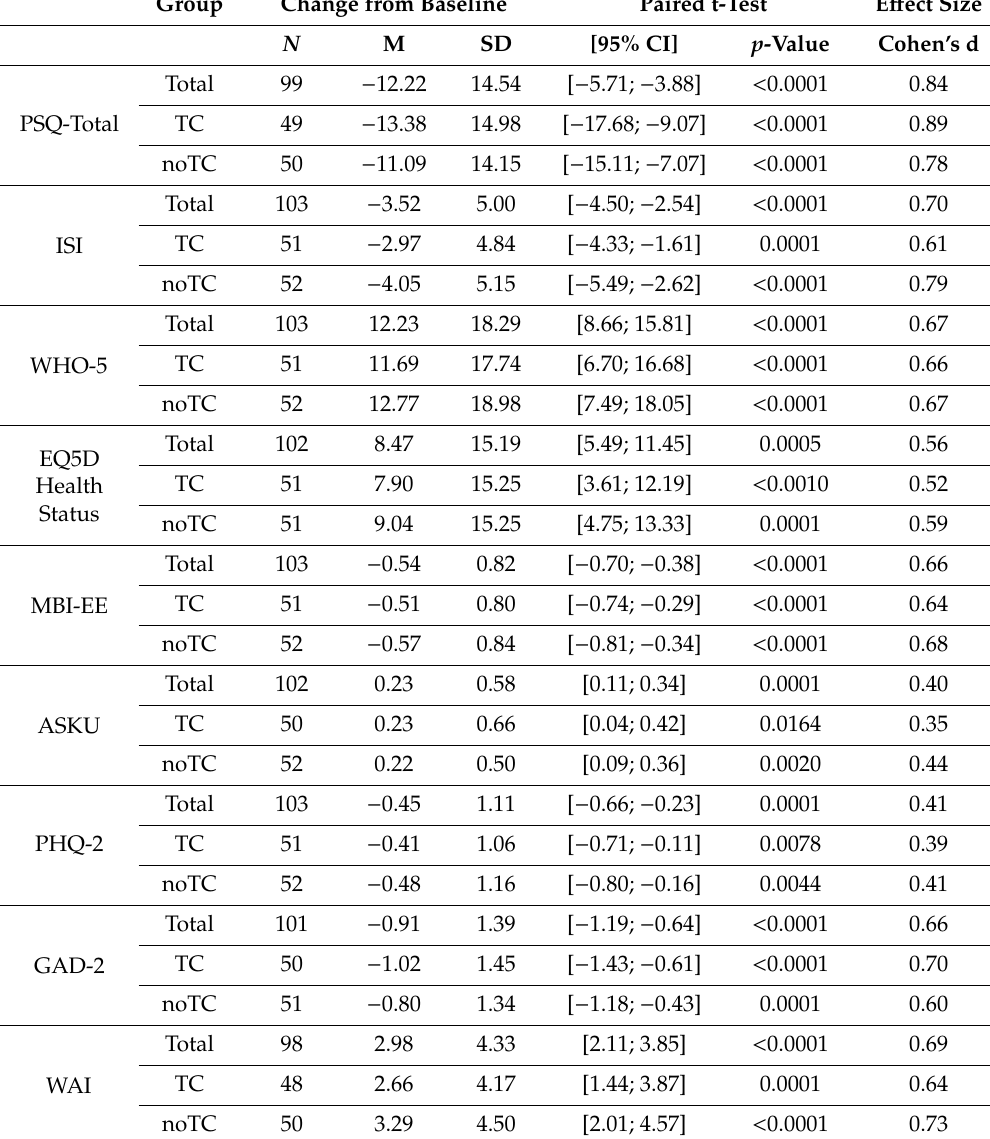
Table 4. Change over time within the total group and within TC and noTC groups—mean di ff erences at 9-month follow-up compared to baseline (t-test and e ff ect sizes for paired